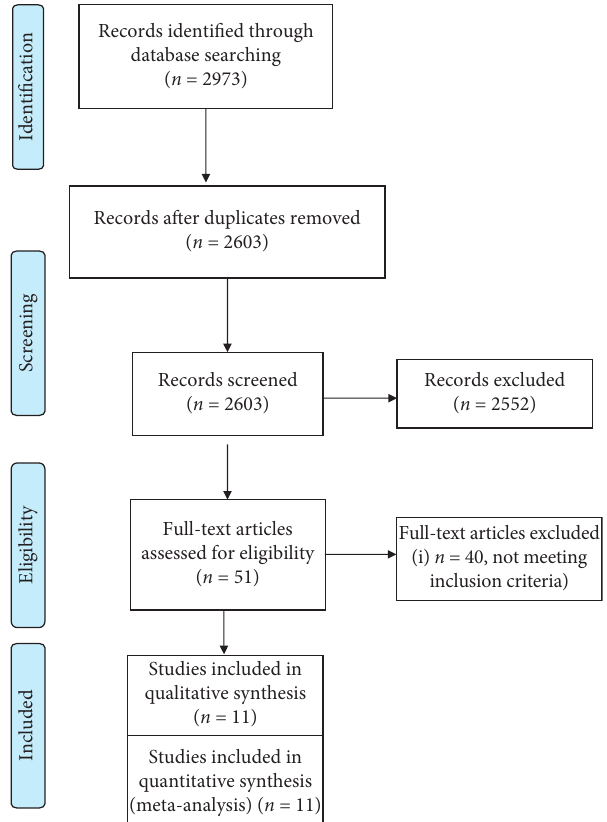
Figure 1: PRISMA flow diagram showing the articles screened for eligibility as per the inclusion criteria to be included in the sys- tematic review and